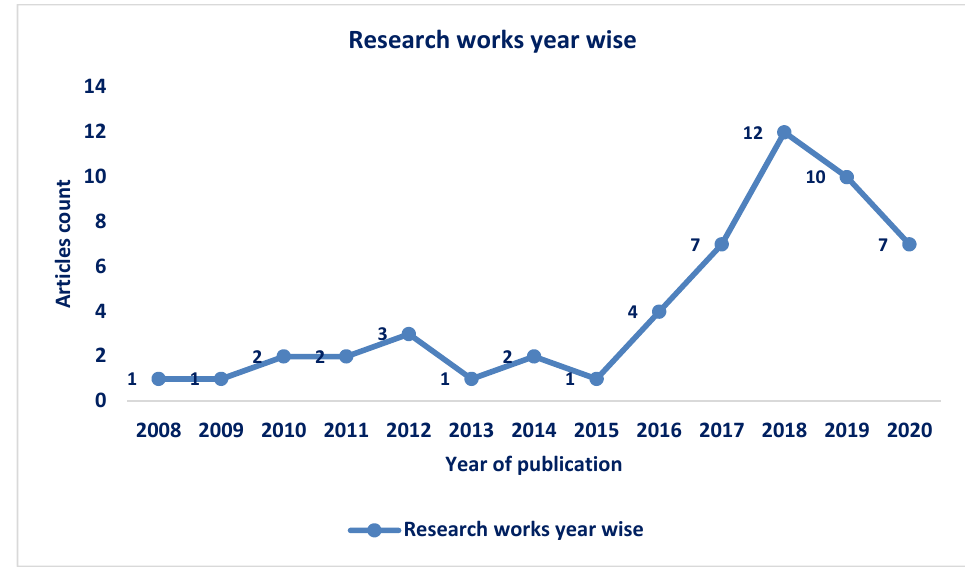
Figure 4. Year-wise publication of research articles in journals/conferences.